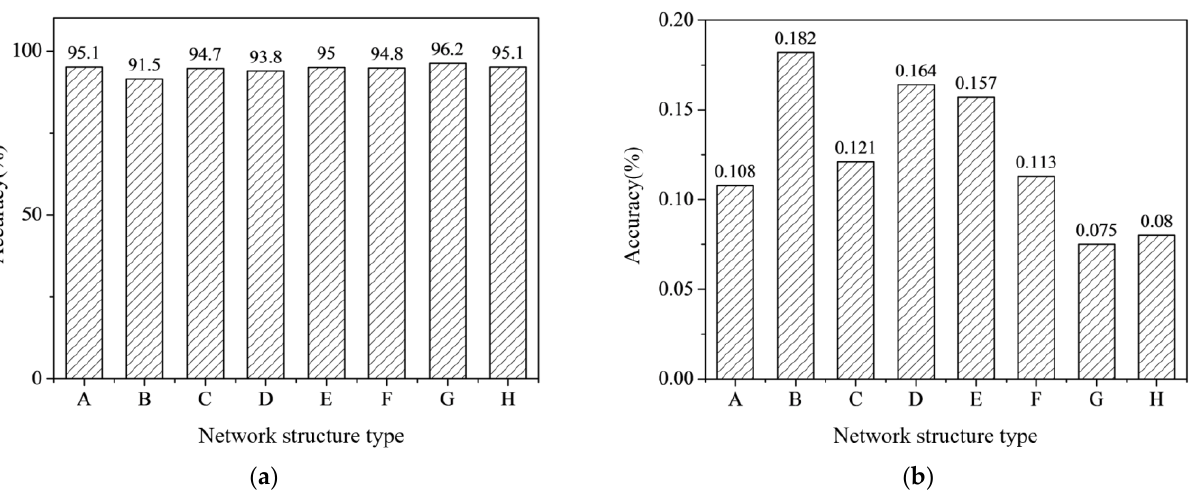
Figure 8. Accuracy comparison and cross-entropy loss comparison of each network structure model. ( a ) Accuracy comparison; ( b ) Cross entropy loss comparison.